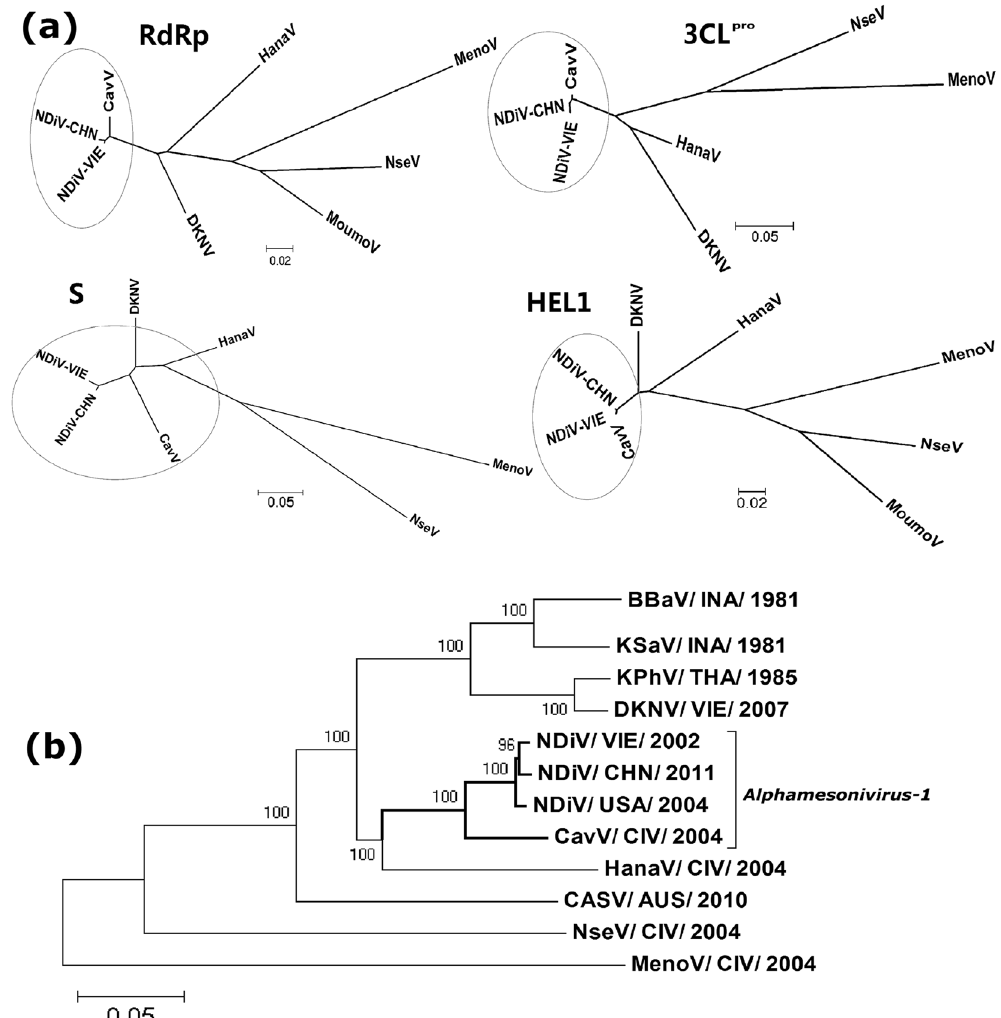
Figure 3. Neighbor-joining (NJ) phylogenetic trees of the members of the family Mesoniviridae. ( a ) Phylogenetic comparison of mesoniviruses based on the amino acid sequences of the conserved domains of proteins including 3C-like chymotrypsin-like protease (3CL pro ), superfamily 1 helicase (Hel1), putative RNA- dependent RNA polymerase (RdRp) and putative spike glycoprotein (S). ( b ) Evolutionary relationships of the putative proteins 1ab of 9 putative mesonivirus species ( Alphamesonivirus - 1 - 9 ). The virus names and GenBank accession numbers are as follows: NDiV/CHN/2011, Nam Dinh virus isolate SZ11706Z (KF522691); NDiV/ VIE/200, Nam Dinh virus isolate 02VN178 (DQ458789); NDiV/USA/2004, Nam Dinh virus isolate V3872 (KC807175); CavV/CIV/2004, Cavally virus isolate C79 (HM746600); MenoV/CIV/2004, Meno virus strain E9/ CI/2004 (JQ957973); NseV/CIV/2004, Nse virus strain F24/CI/2004 (JQ957874); HanaV/CIV/2004, Hana virus strain A4/CI/2004 (JQ957872); DKNV/VIE/2007, Dak Nong virus (AB753015); CASV/AUS/2010, Casuarina virus